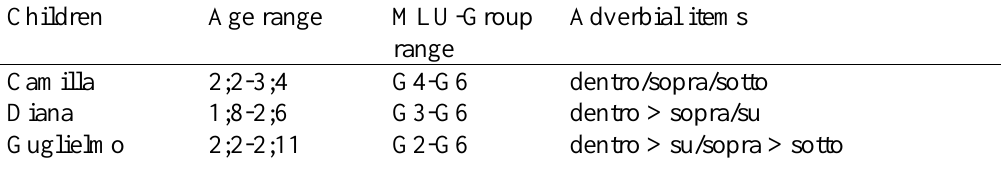
Table 6 . Order of production of the adverbial prepositional items across children